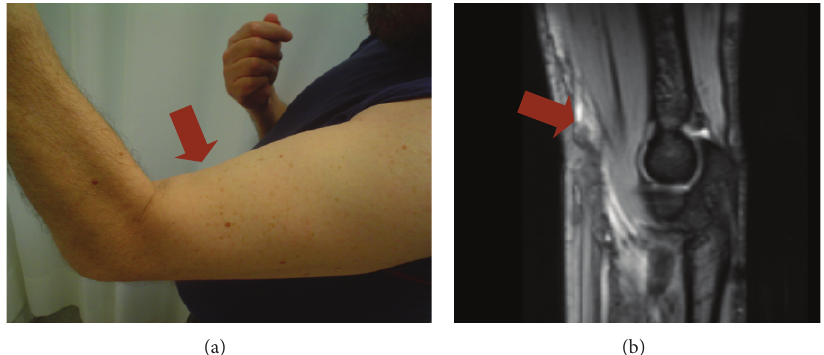
Figure 1: Clinical and MRI image of the myotendinous rupture of the biceps brachii muscle.